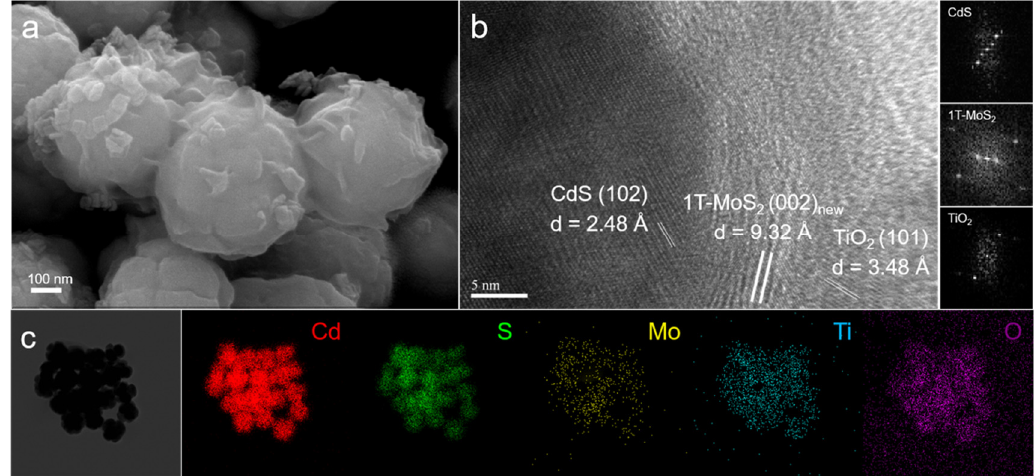
Figure 2. ( a ) SEM image and ( b ) high-resolution transmission electron microscopy (HRTEM) image of CdS/1T-MoS 2 /TiO 2 - 45-15 heterojunction. ( c ) EDS element mapping images of Cd, S, Mo, Ti, and O in the CdS/1T-MoS 2 /TiO 2 -45-15.